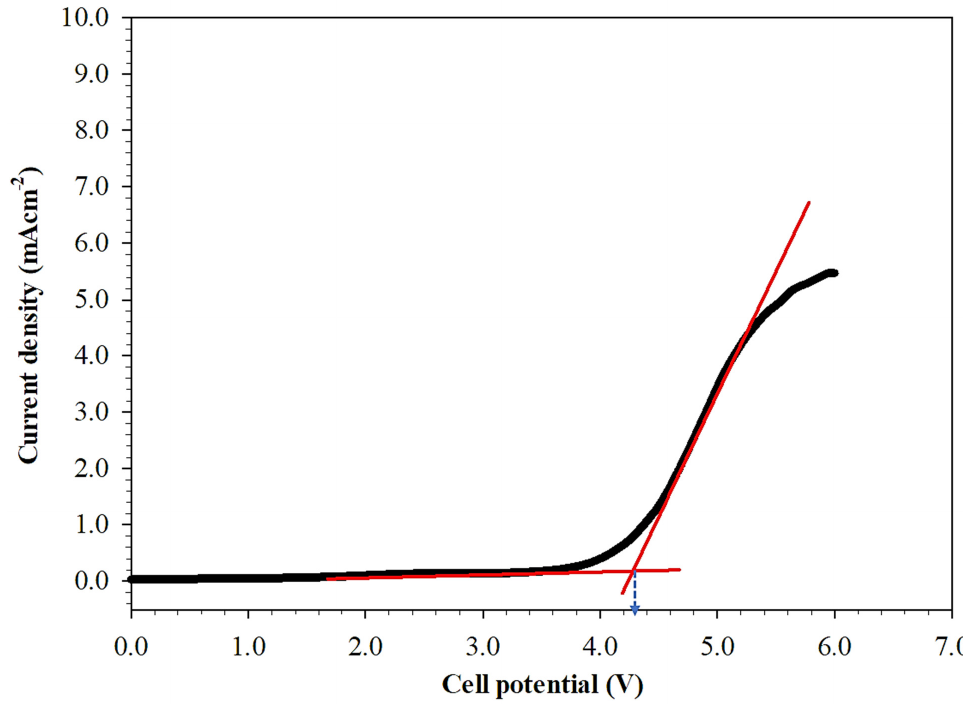
Figure 6. Linear sweep voltammetry of the highest conducting film containing 60% of [BMIM][BF 4 ] to PVDF-HFP.